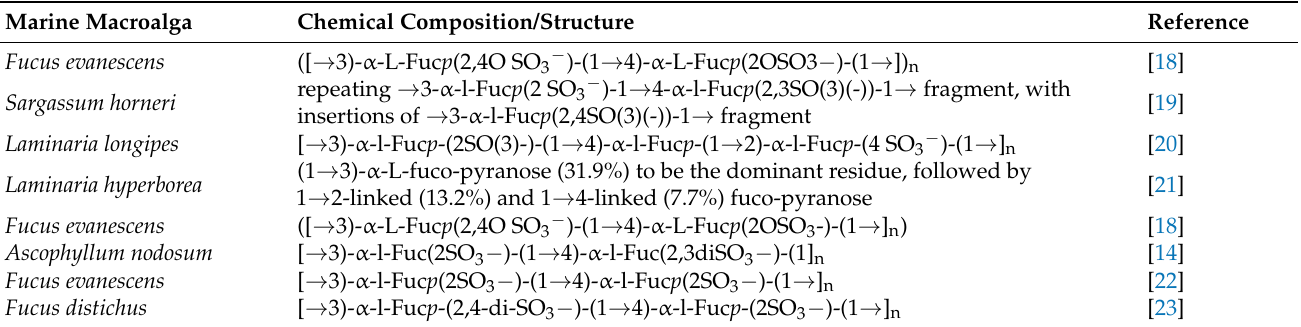
Table 1. Marine macroalgal sources of fucoidan